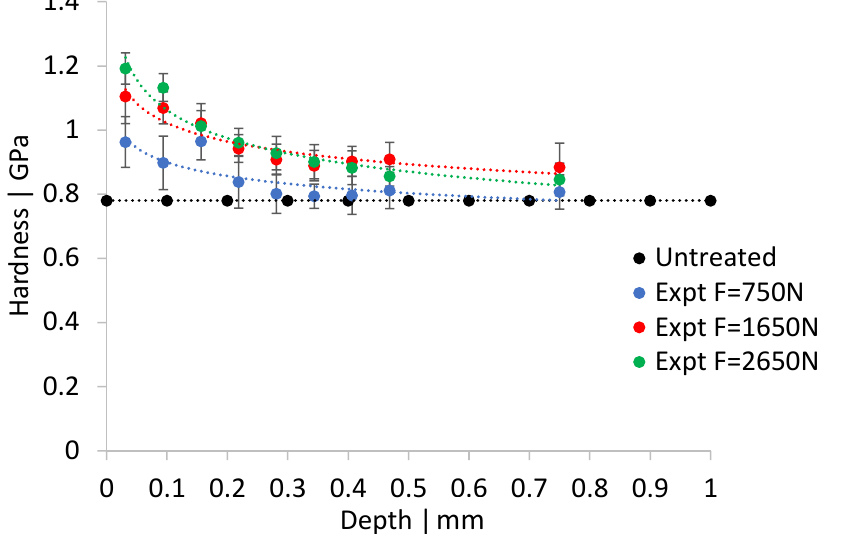
Figure 15. Experimental hardness with respect to the burnishing force. The error bar at each data point indicates the standard deviation of the measurement.